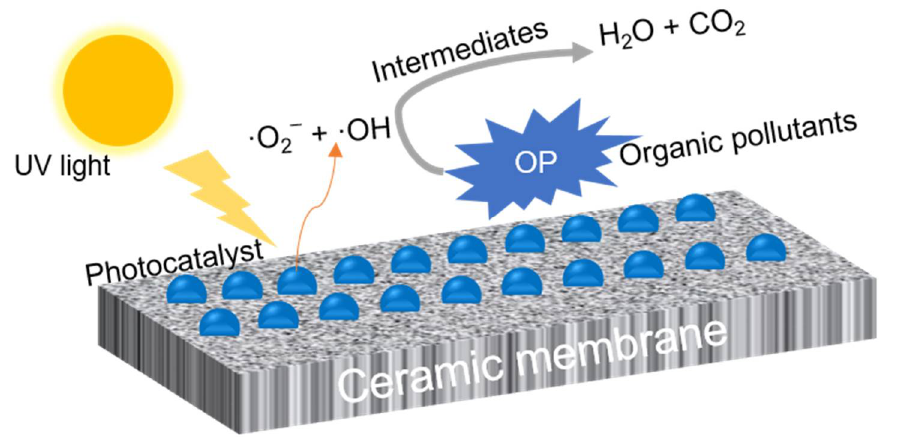
Figure 2. Schematic diagram depicting mechanisms that organic pollutants degradation on the photocatalytic ceramic membrane surface.